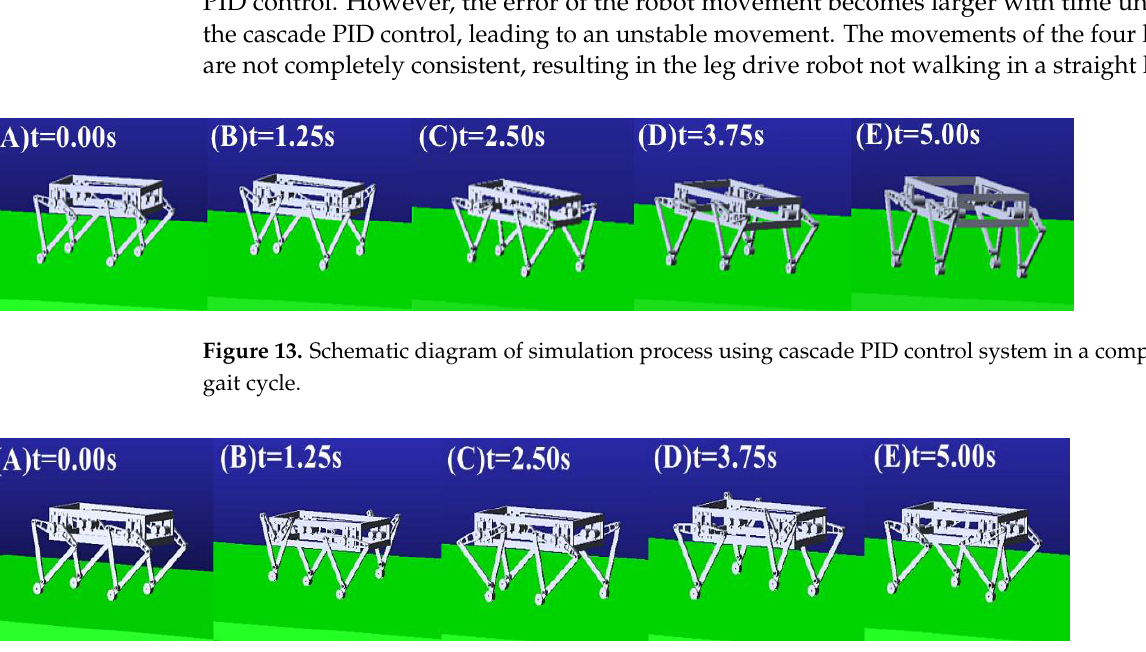
( b ) Z direction Figure 12. Comparison of foot velocity before and after optimization: ( a ) foot velocity curves in X direction cascade PID (1) and fuzzy adaptive PID (2); ( b ) foot velocity curves in Z direction cascade PID (1) and fuzzy adaptive PID (2). The simulation results demonstrate that the robot can walk forward using the cascade PID controller. However, there is a large error during the combined motion of the